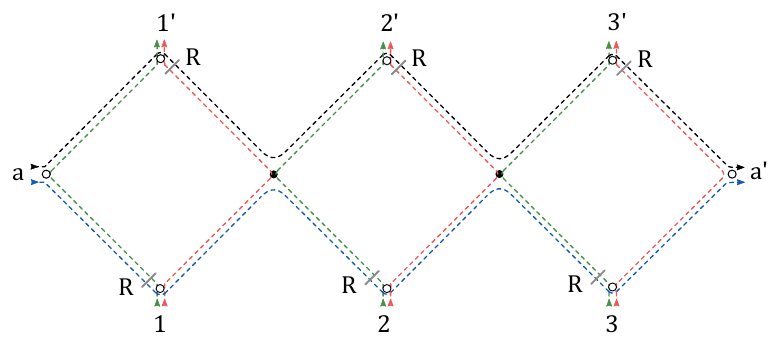
Figure 15 . Integral kernel of the monodromy matrix operator T 1 , 2 , 3 ,a ( u ) obtained from the con- volution of operators R ( u + θ ) in the auxiliary space V for k = 1 , 2 , 3 . The black blobs are ka k a integrated, the circles are external coordinates. Black and blue lines denote the propagation of Weyl spinors in the auxiliary space ( ‘ 0) and (0 , ˙ ‘ ) , while the red and green lines are Weyl spinor a , a propagators in the representations ( ‘ 0) or (0 , ˙ ‘ ) of the physical spaces V , k = 1 , . . . , L . The k , k k mixing of spinorial indices between auxiliary (black, blue) and physical (red, green) representations is given by the SU(2) R-matrices denoted with a grey line. The transfer matrix t ( a ) ( u ) is obtained by the identification and integration of the points x and x 0 a a